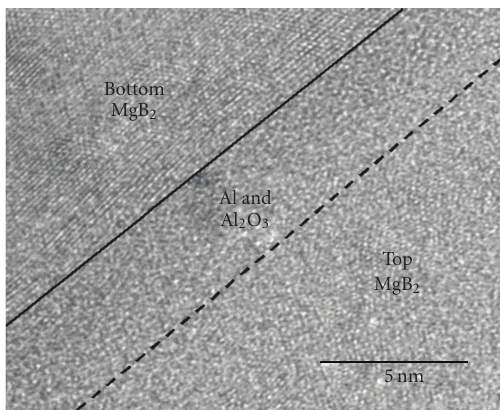
Figure 8: (From [28]) Cross-sectional TEM image of an all-MgB 2 junction with an Al 2 O 3 barrier. The bottom electrode is crystalline, whereas the barrier and top electrode are clearly randomly oriented. c (cid:2) American Institute of